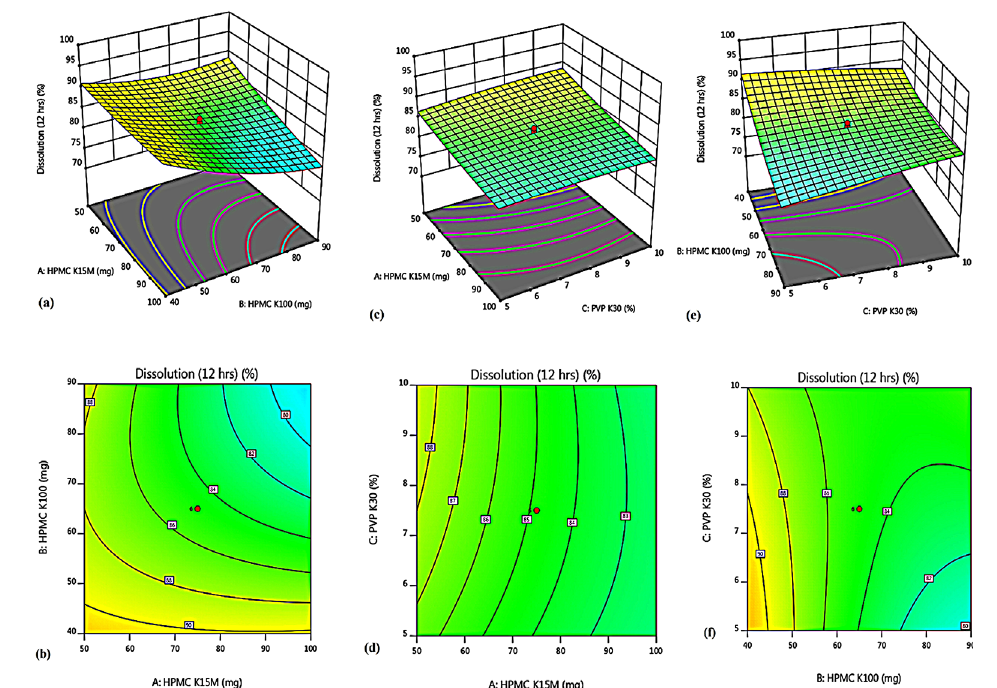
FIGURE 3 - (a) 3D response surface plot for “response-3” obtained by “A” Vs “B” (b) 2D contour plot for “response-3” obtained by “A” Vs “B” (c) 3D response surface plot for “response-3” obtained by “A” Vs “C” (d) 2D contour plot for “response-3” obtained by “A” Vs “C” (e) 3D response surface plot for “response-3” obtained by “B” Vs “C” (f) 2D contour plot for “response-3” obtained by “B” Vs